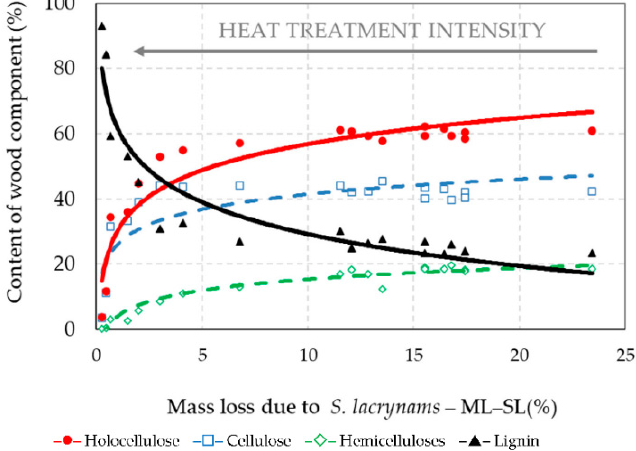
Figure 6. The percent content of wood components of the thermally–fungally attacked spruce wood according to the mass loss caused by S. lacrymans (Correlation equations are listed in Table 2). Table 2. Correlations between the percent content of wood components and the mass loss of the Norway spruce wood samples during fungal attack by S. lacrymans